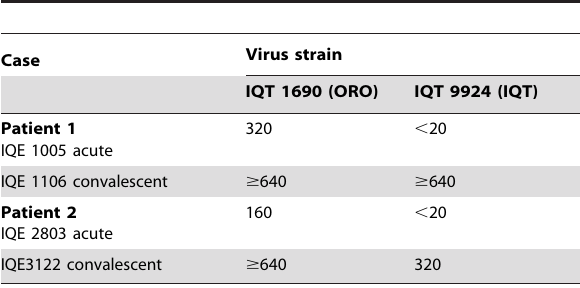
Table 4. Antigenic characterization of ORO and IQT9924 (IQT) viruses.